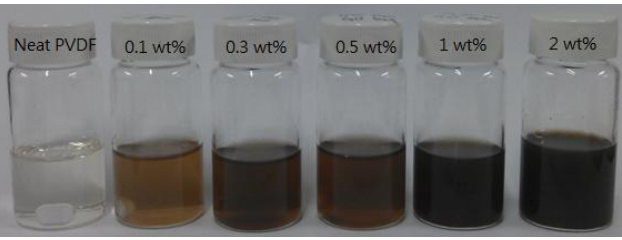
Figure 1. The solutions of GO-doped PVDF in